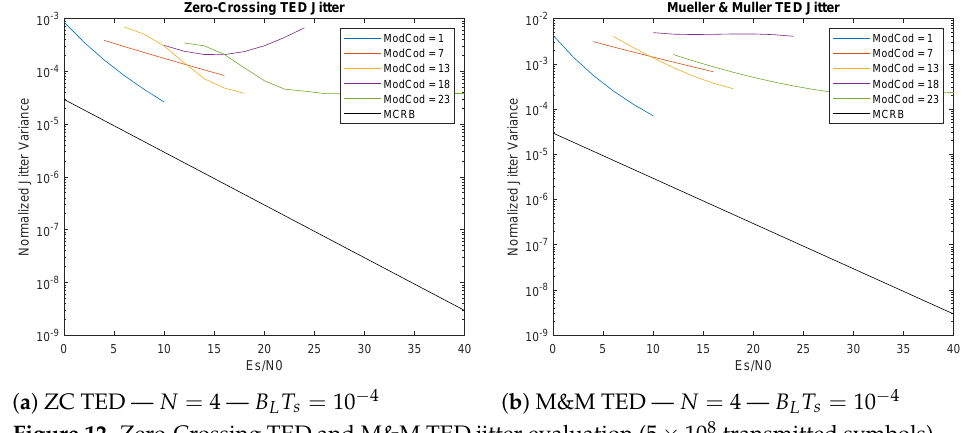
( b ) M&M TED — N = 4 — B L T s = 10 − 4 Figure 12. Zero-Crossing TED and M&M TED jitter evaluation (5 × 10 8 transmitted symbols). Finally the feedforward systems are the one providing the best performance (i.e., Figure 13) at the same B L T s . The Oerder and Meyr technique shows about x6 reduced jitter when compared to the Gardner and Early-Late feedback loops at low SNRs. At high SNR (i.e., E s / N 0 = 26 dB with 64-APSK) this difference is reduced to × 1.69. When compared to the Lee estimator the performances of Oerder and Meyr TED provide almost the same jitter profile up to Es / N 0 = 24 dB, while at higher SNRs the O&M converges to a floor level having about 30% reduced jitter w.r.t Lee’s TED. However, it has to be considered that Lee’s estimator runs at oversampling N = 2, while O&M is forced to a value equal or higher than 4 (e.g., N = 4 in this analysis). This represents a big improvement in high data-rate environments where the parallelization level, thus complexity, linearly depends on the oversampling factor of the receiver more than the algorithmic difference between the two (which are very similar).